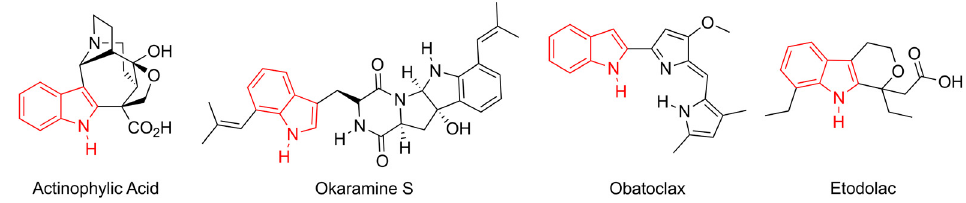
Figure 1. Privileged natural products and pharmaceutics containing indole